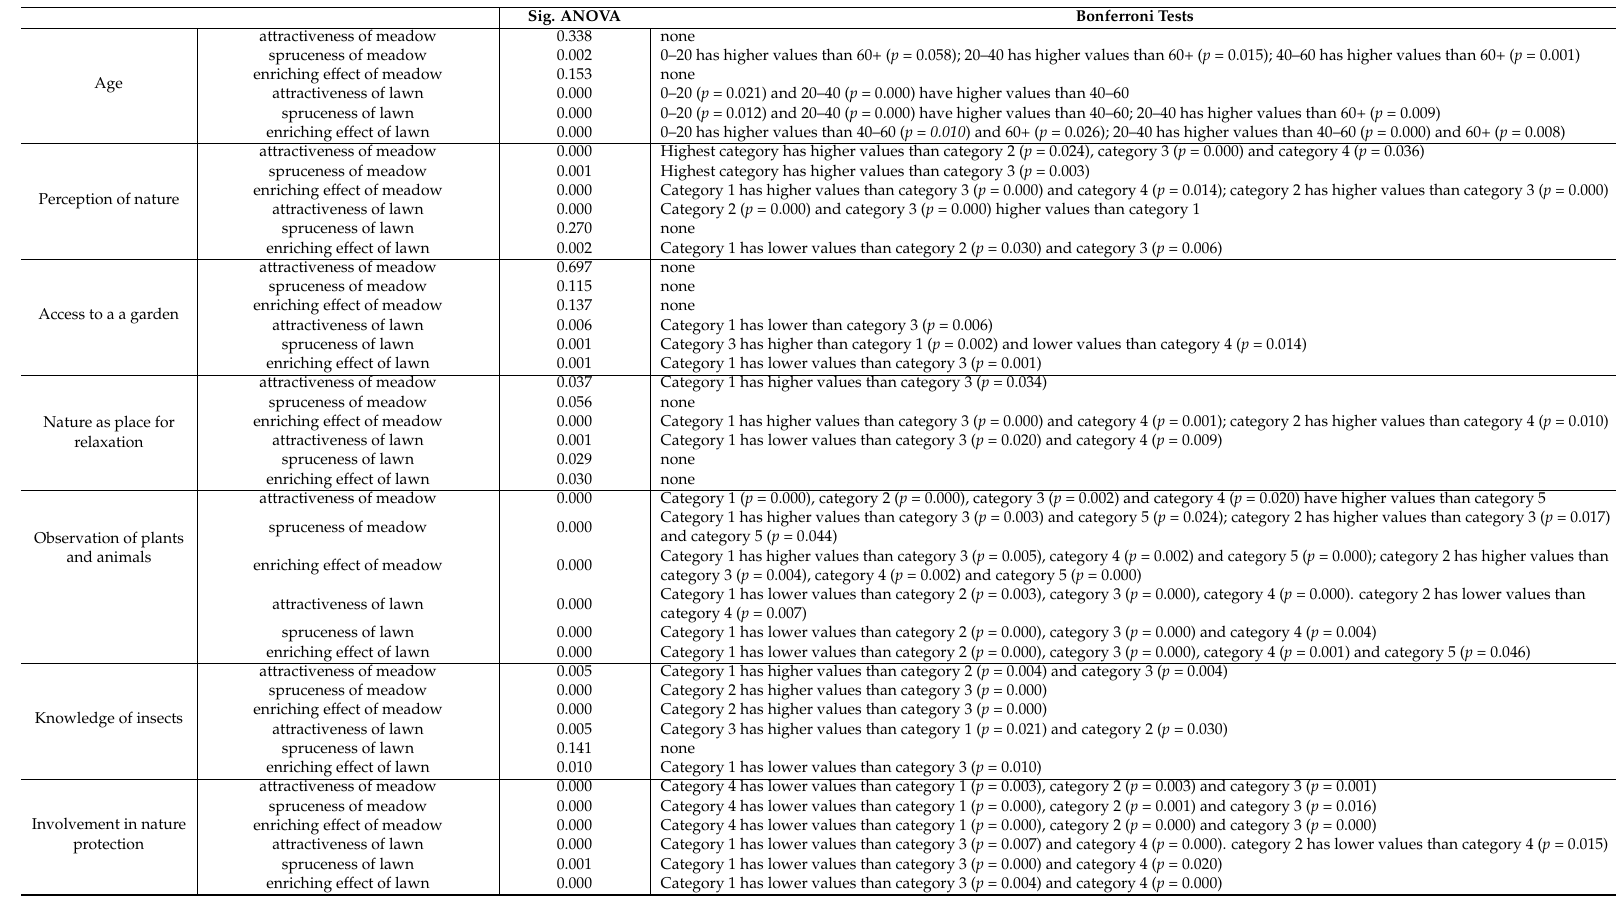
Table 4. Influence of demographic and behavioural data on the perception of lawns and meadows. The significance level of the one-way ANOVA (analysis of variance) and the results of the Bonferroni tests are given. The given categories correspond to the categories of Table 1. n =